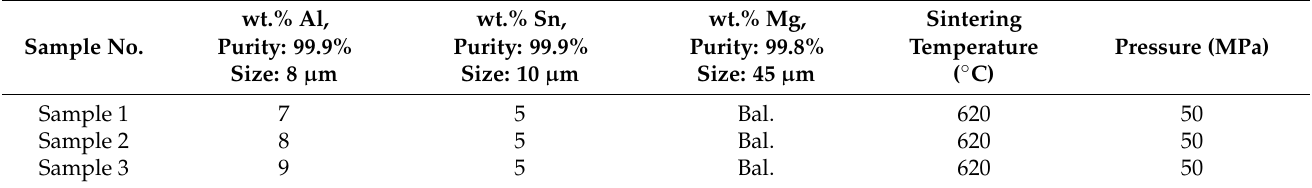
Table 2. The chemical compositions of the Mg alloys.